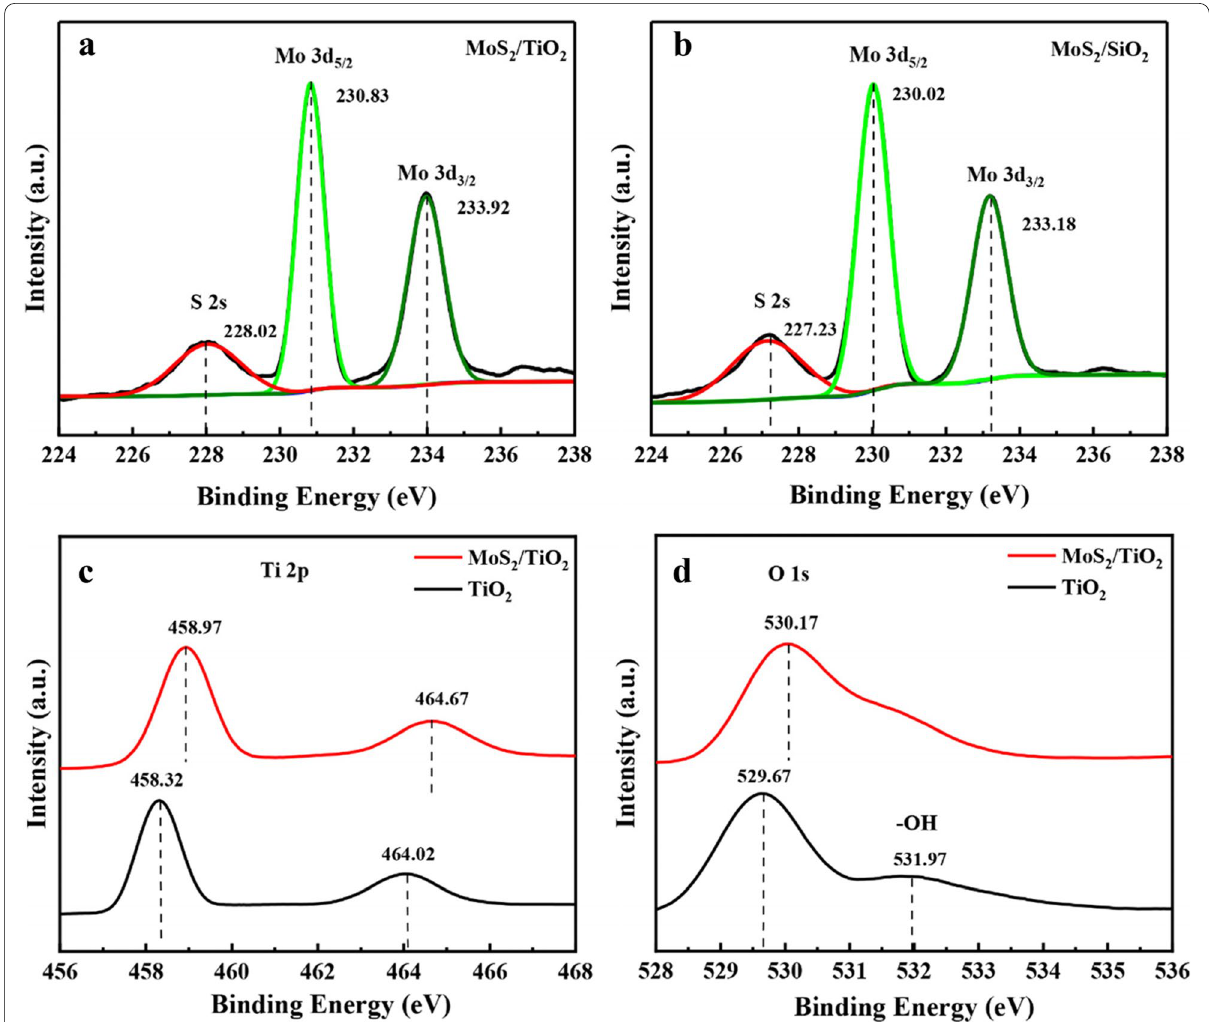
Fig. 3 a , b Normalized Mo 3d spectra of as-prepared MoS 2 monolayer belt-like structures on Rutile-TiO 2 (001) substrate and of transferred MoS 2 onto SiO 2 /Si surface, respectively. c , d XPS spectra of Ti 2p ( c ) and O 1s ( d ) collected on as-prepared MoS 2 /TiO 2 (red curve) and on the Rutile-TiO 2 (black